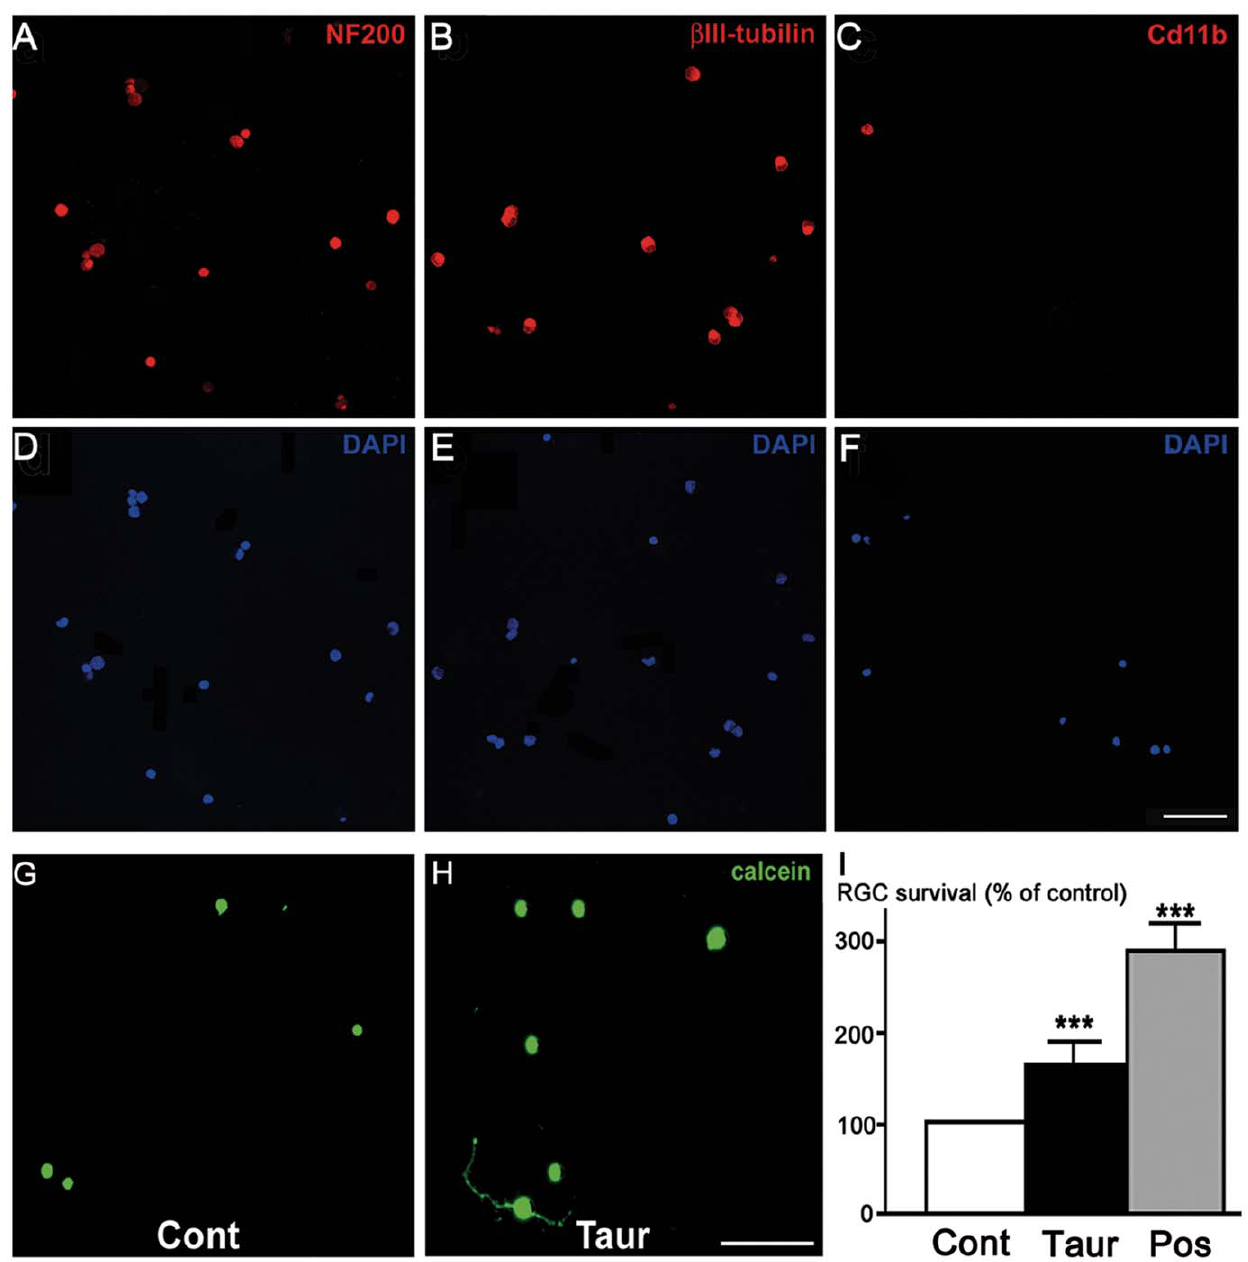
Figure 1. Taurine stimulates the survival of pure adult retinal ganglion cells (RGCs) in culture. A–F) Purity of RGC cultures. Confocal representative images of pure RGC cultures immunolabeled with specific RGC markers, NF-200 (red in A) or b III-Tubulin (red in B), as well as with a specific marker for microglia/macrophages, Cd11b/c (red in C), while all isolated cells were stained by the nuclear dye DAPI (blue in D–F). Note that most cells were immunolabeled with the RGC markers (NF-200 or b III-Tubulin) (A,B,D,E) whereas a very few cells were positive for the macrophage marker (C,F). G–H) Effect of taurine on pure RGCs. Representative images showing viable cultured RGC labeled with calceinAM, after 6 days in vitro (6 DIV), in the negative control condition (Cont; G) and following 1 mM taurine application (Taur; H). I) Quantification of RGC densities after 6 DIV either in the control condition (Cont; white bar), with 1 mM taurine application (Taur; black bar), or with the B27 supplement, providing a positive control condition (Pos; grey bar). In each experiment, the respective RGC densities were expressed as a percentage of the negative control condition at 6 DIV. Illustrated data are means 6 s.e.m. from 21 independent experiments. ***p , 0.001, one-way ANOVA followed by a Dunns post-hoc test. Scale bars represent 100 m m in panels (A–H). doi:10.1371/journal.pone.0042017.g001 plasma level of taurine ( + 106%; p , 0.01, Fig. 4D), while no dispersion (Fig. 4B–C) nor significantly reduced IOP increases significant difference was found in the basal plasmatic taurine level (Fig. 4E). To quantify RGC survival, retinal cryo-sections were between untreated DBA/2J and C57BL/6J mice (Fig. 4D). prepared along the ventro-dorsal axis at 500 m m from the optic However, taurine treatment neither modified the pigment nerve and immunolabeled against POU4F1 (Brn3a) (Fig. 4F–I).